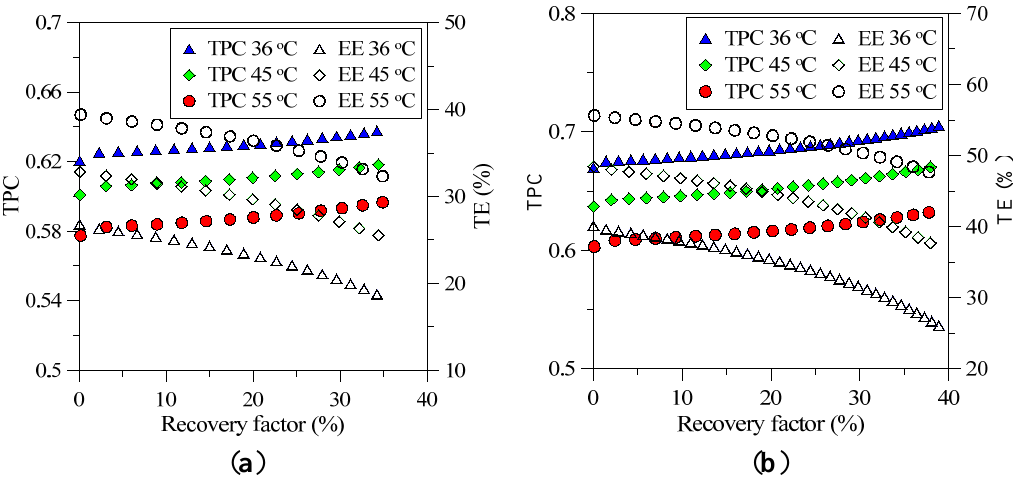
Figure 4. TPC and TE of PP ( a ) and PVDF ( b ) membranes as function of RF at various